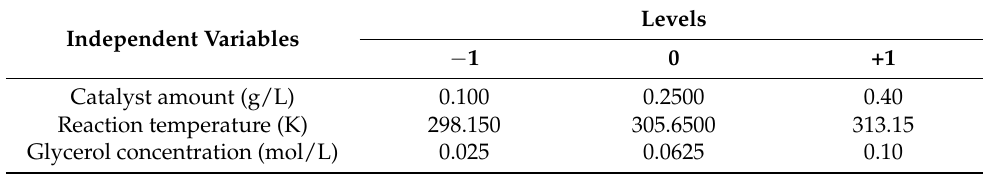
Table 7. Levels of the independent variables for the selective photo-oxidation of glycerol. Levels Independent Variables − 1 0 +1 Catalyst amount (g/L) 0.100 0.2500 0.40 Reaction temperature (K) 298.150 305.6500 313.15 Glycerol concentration (mol/L) 0.025 0.0625